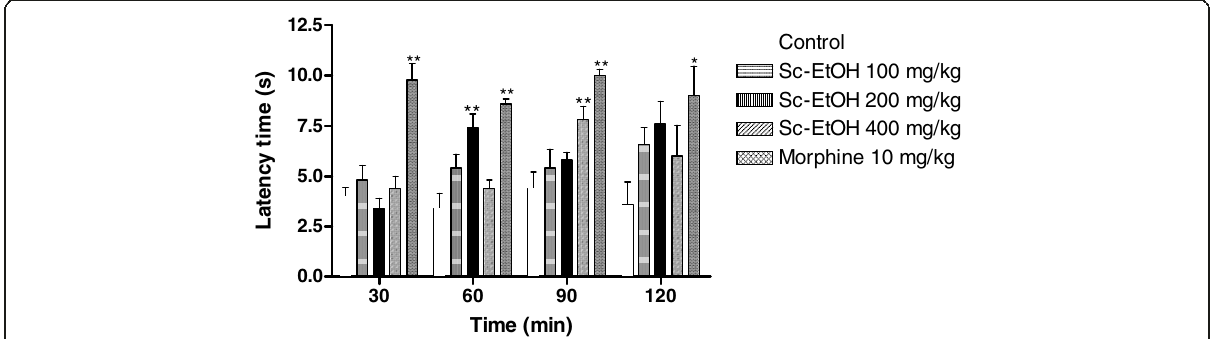
Figure 5 Effect of ethanolic extract of Selaginella convoluta (Sc-EtOH) and morphine on hot plate test. Values are mean ± S.E.M.; *p < 0.05, **p < 0.01, significantly different from control; ANOVA followed Dunnett ’ s test (n = 6, per